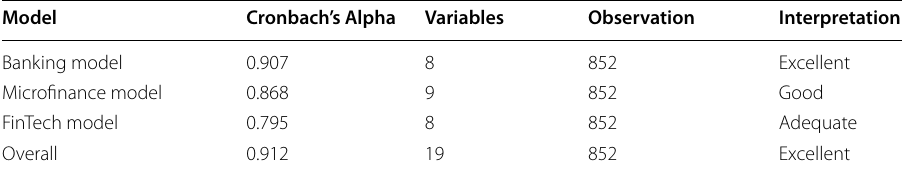
Table 3 Reliability statistics. Source : Author